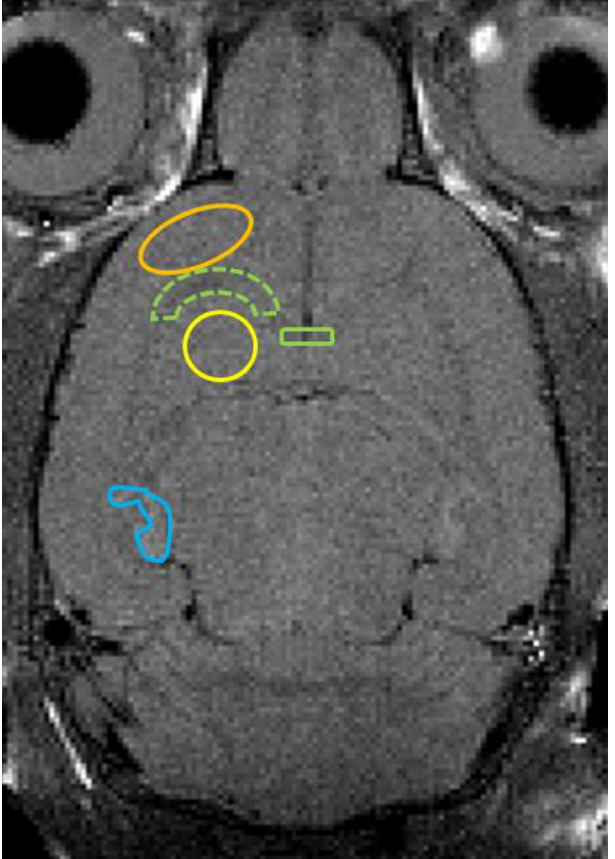
Figure 1. Axial T 2 -weighted image shows ROI placements on the cerebral cortex (orange line), white matter (green dotted line), striatum (yellow line), corpus callosum (green line), and hippocampus (blue line).